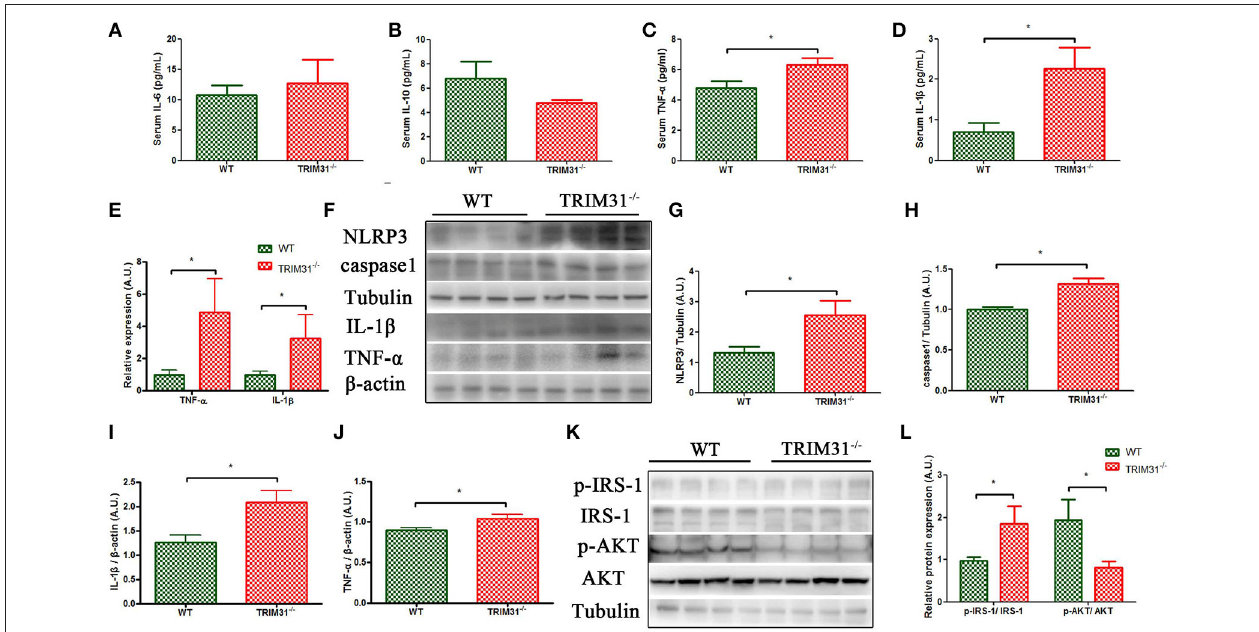
FIGURE 5 | Elevated level of pro-inflammation cytokines in TRIM31 − / − mice. (A–D) Serum IL-6, IL-10, TNF- α , and IL-1 β concentrations, (E) qRT-PCR of mRNA levels of TNF- α and IL-1 β . (F–J) Western blot analysis of caecal protein levels of TNF- α , IL-1 β , caspase-1,and NLRP3. (K–L) Western blot analysis of p-IRS-1 and p-Akt protein levels in visceral adipose tissue. n = 10, in each group. * P < 0.05, TRIM31 − / − vs. WT mice. IL-6, interleukin-6; IL-10, interleukin-10; TNF- α , tumor necrosis factor- α ; IL-1 β , interleukin-1 β ; p-IRS-1, phosphorylated- insulin receptor substrate-1; p-Akt, phosphorylated-Akt.